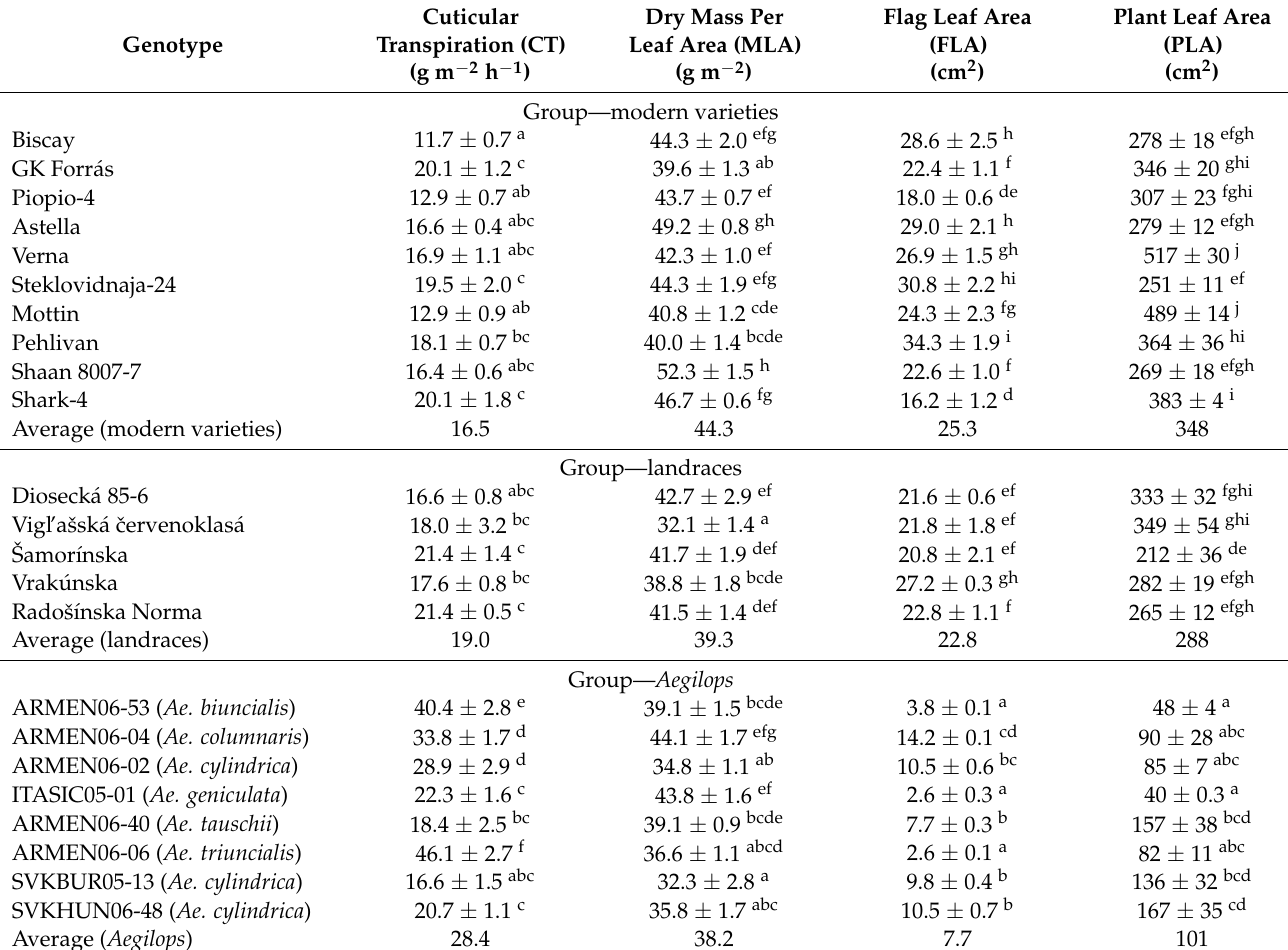
Table 1. Leaf traits analyzed in three groups of Triticeae genotypes #